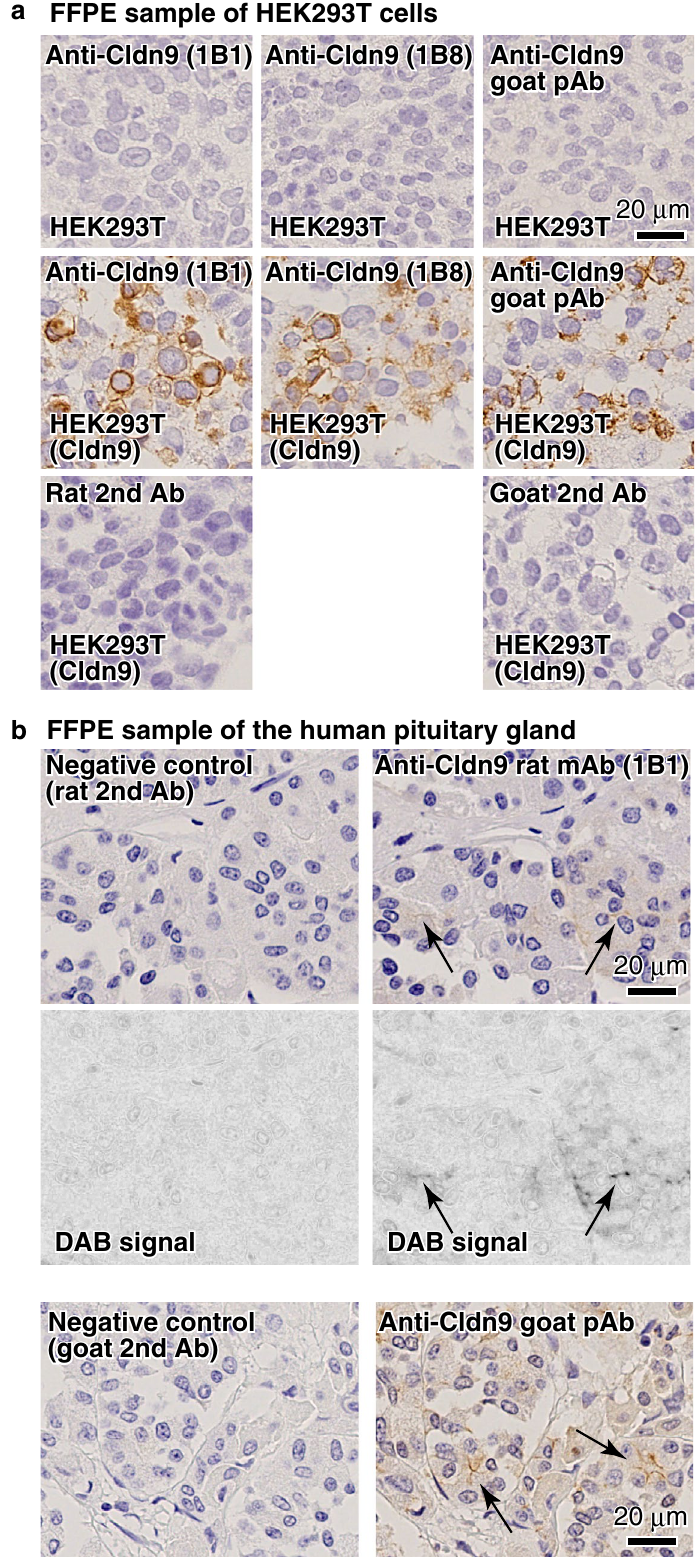
Figure 6. Anti-claudin-9 is applicable for immunohistochemistry. ( a ) Immunocytochemical staining of FFPE samples of HEK293T cells expressing human CLDN9 using anti-claudin-9 mAbs (clones 1B1 and 1B8) and anti-claudin-9 pAb. ( b ) Immunohistochemical staining of FFPE samples of the human pituitary gland using anti-claudin-9 mAb (clone 1B1) and anti-claudin-9